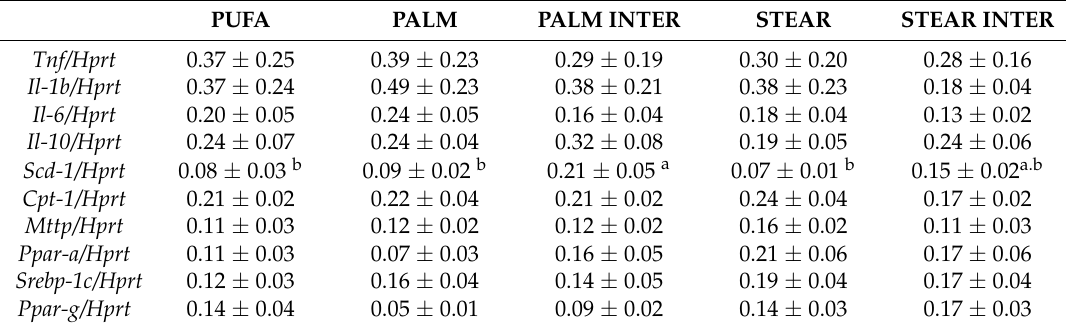
Table 5. Liver mRNA related to inflammatory and metabolic pathways of LDLr-KO mice fed experimental diets for 16 weeks. PUFA PALM PALM INTER STEAR STEAR INTER 0.37 ± 0.25 0.39 ±